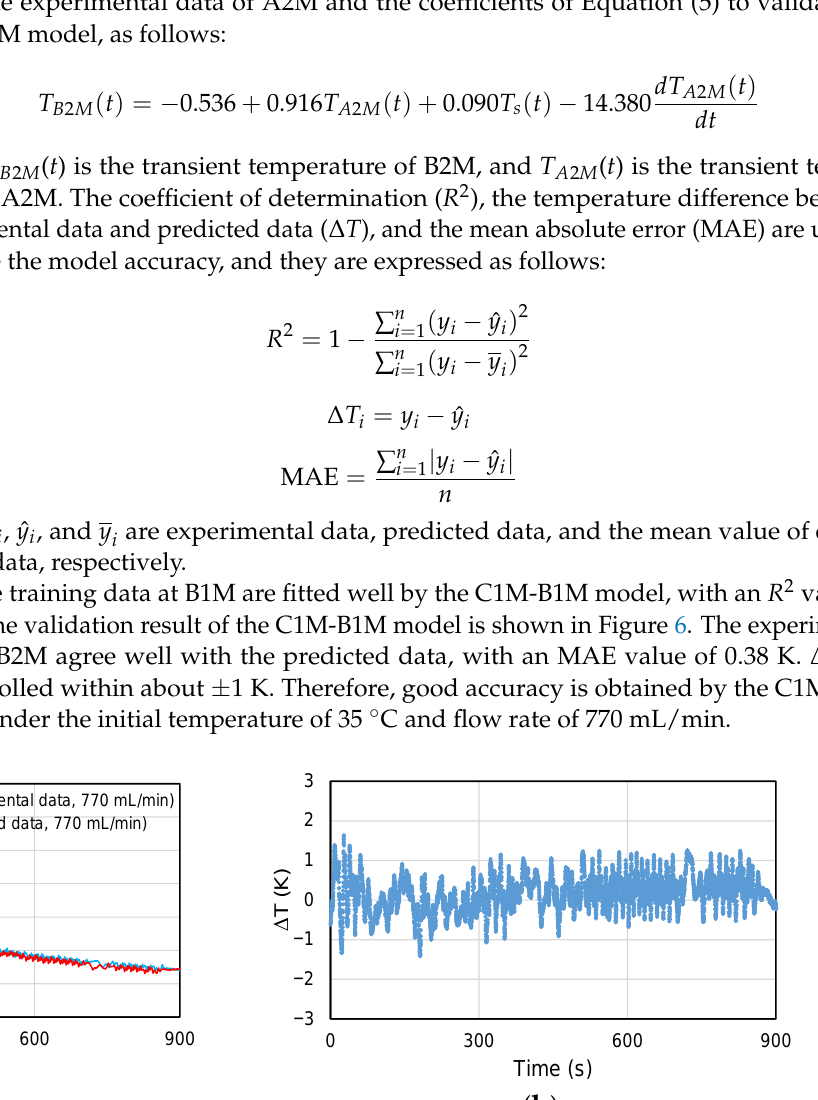
model under the initial temperature of 35 ◦ C at the flow rate of 770 mL/min is expressed as follows: